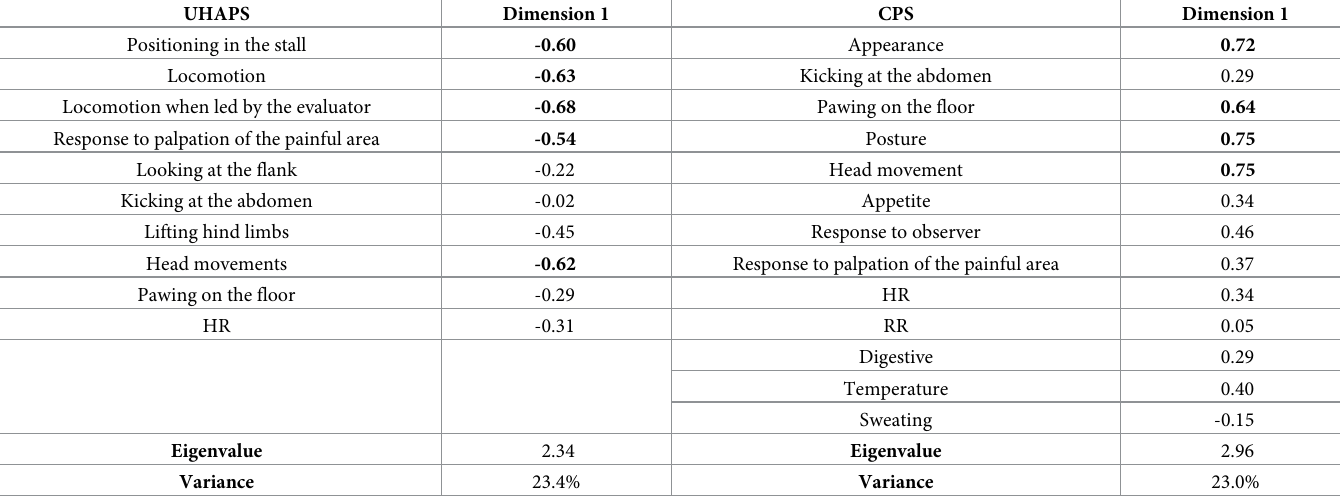
Table 5. Load, eigenvalue, and variance of the Unesp-Botucatu horse acute pain scale (UHAPS) and the Composite Pain Scale (CPS) submitted to principal compo- nent analysis.